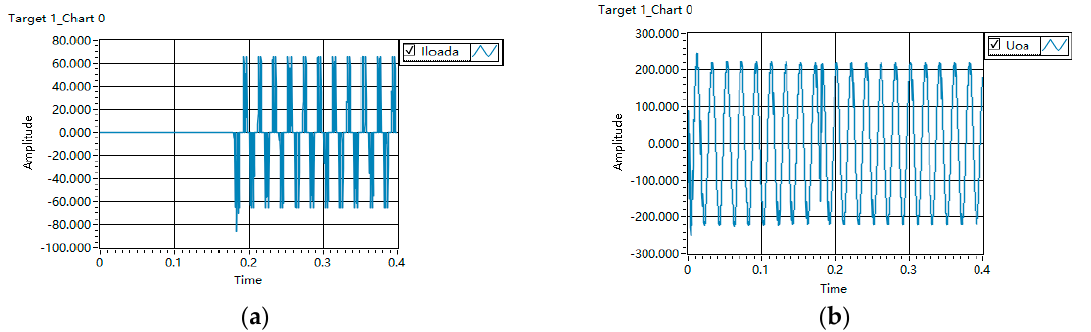
Figure 16. Experimental results of UPS with VSG control strategy combined with dynamic switching method ( a ) output load current of phase A, ( b ) output load voltage of phase A.